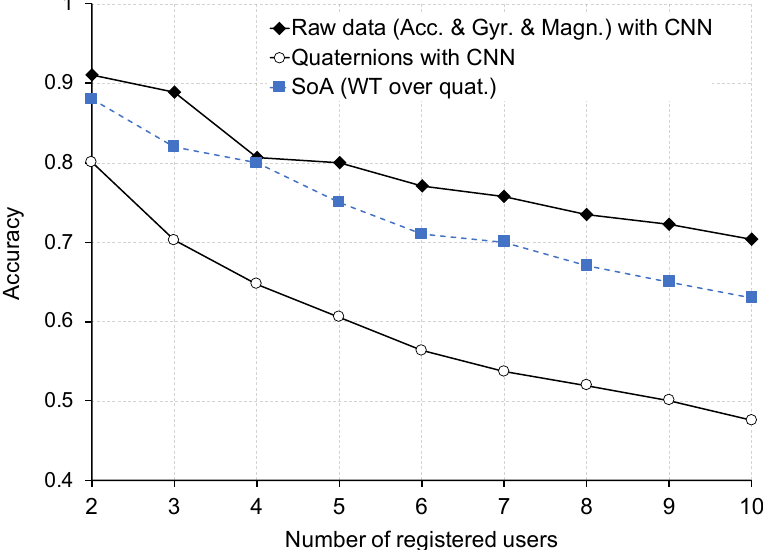
Figure 10. Preliminary experiment results—comparison between CNN with quaternions as input, CNN with raw data (accelerometer (Acc.), gyroscope (Gyr.), and magnetometer (Mgn.), and the state of the art (SoT) in continuous identification, which uses wavelet transform (WT) over quaternions as input and Random Forest (RF) as the ML